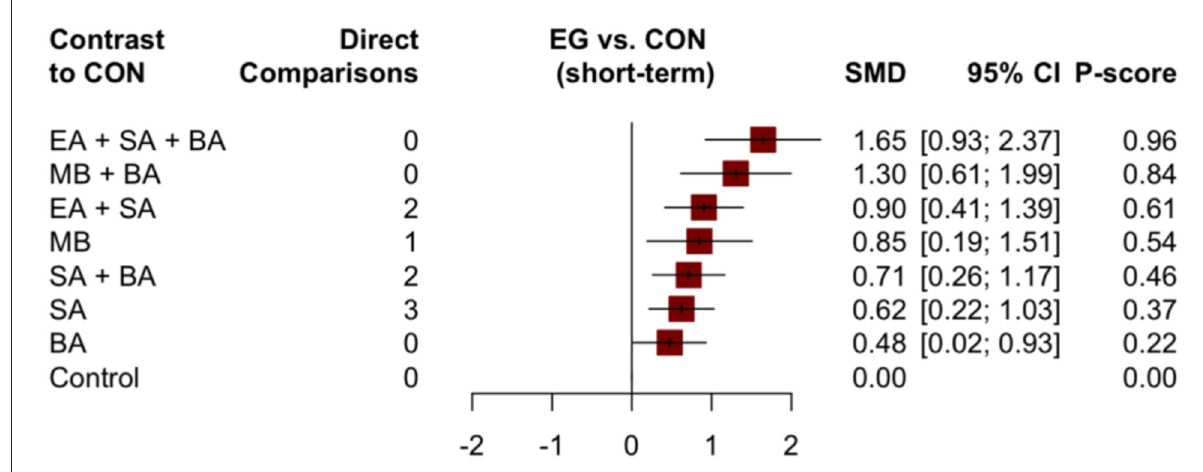
FIGURE5 Forest plot compared with the control group of cognitive function (short-term).